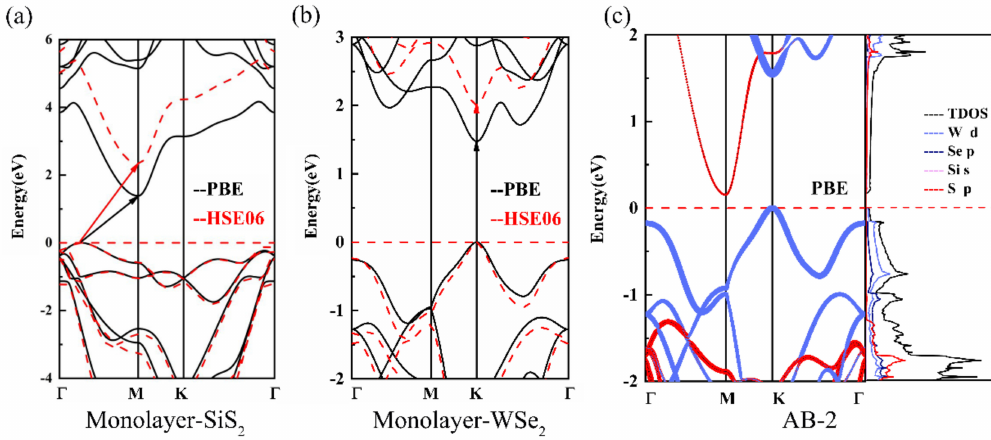
Figure 2. Energy band structures of ( a ) monolayer SiS 2 and ( b ) monolayer WSe 2 . ( c ) Projected band structure and partial density of the state of AB-2 stacking SiS 2 / WSe 2 hetero-bilayer; red and blue lines are bands contributed by SnS 2 and WSe 2